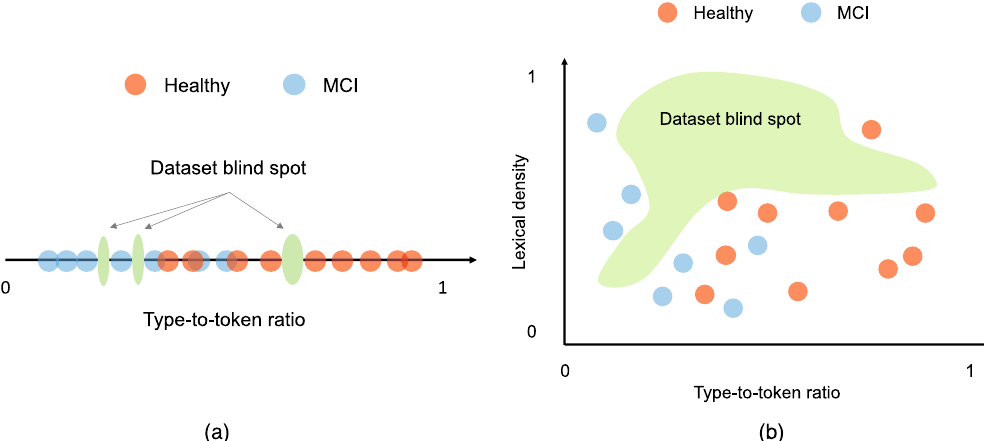
Fig. 2 The two scenarios considered in the example problem in the text. Under the fi rst scenario ( a ), type-to-token ratio is the only relevant feature for distinguishing between healthy controls and patients with mild cognitive impairment (MCI). Under the second scenario ( b ), both type-to-token ratio and lexical density are relevant features for separating between these two